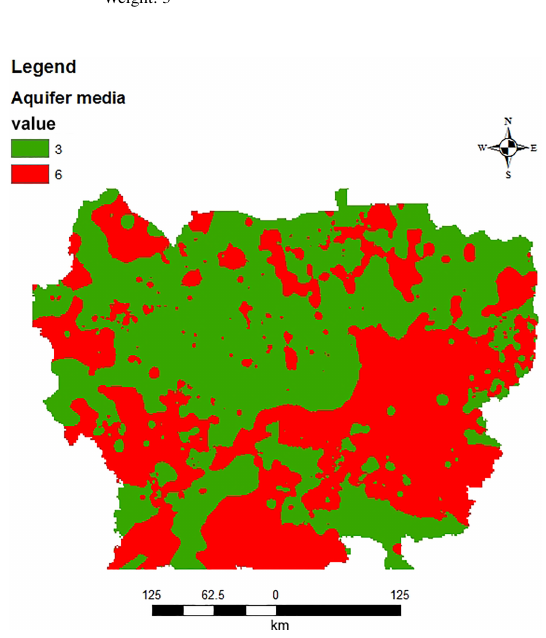
Figure 3. Aquifer media distribution